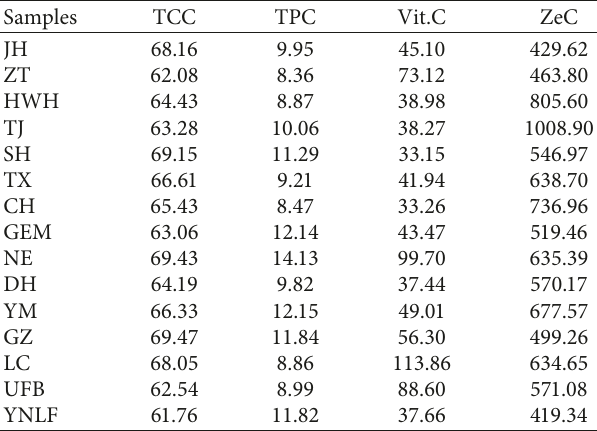
Table 2: TCC, ZeC, Vit.C, and TPC of goji berries.